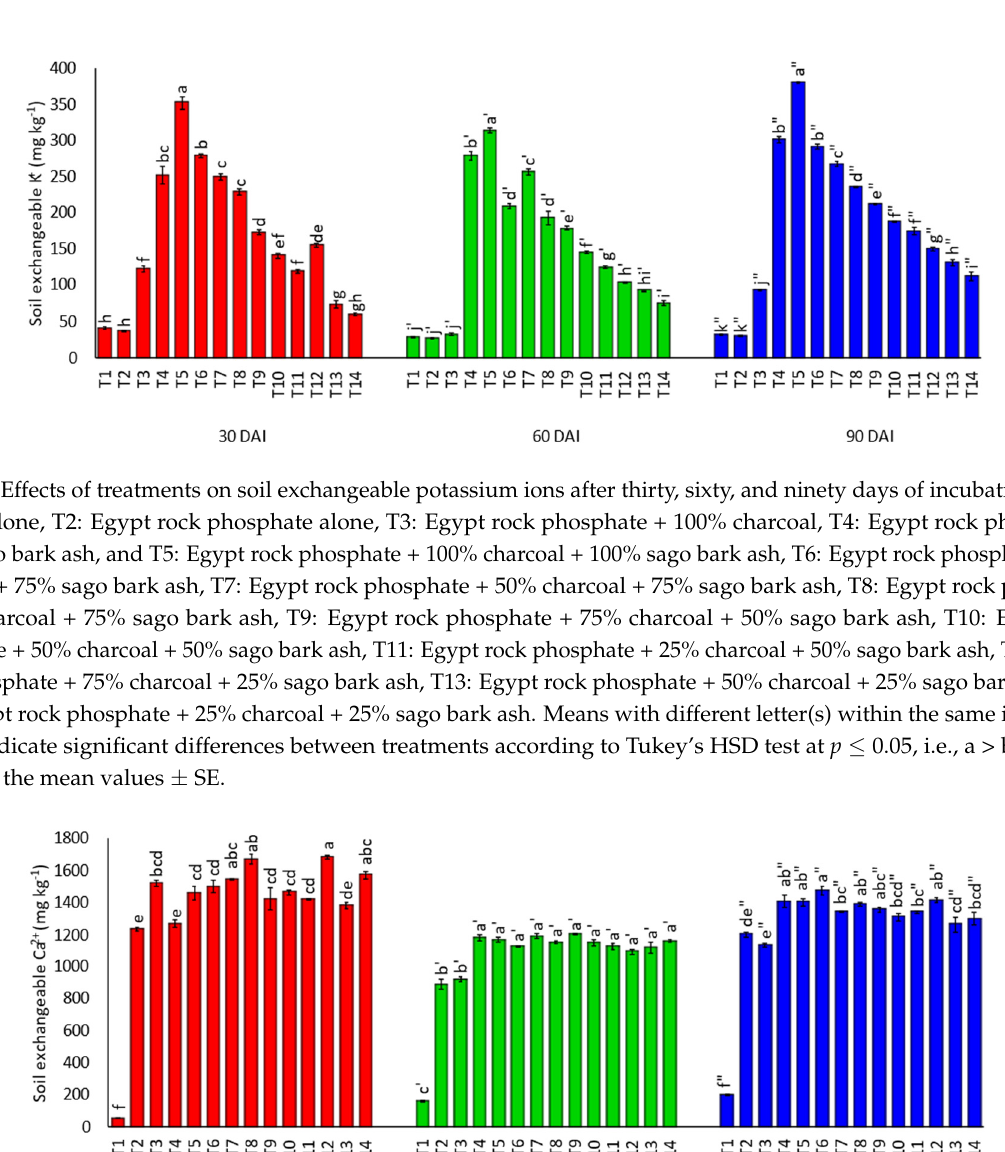
Figure 10. Effects of treatments on soil exchangeable calcium ions after thirty, sixty, and ninety days of incubation, where T1: soil alone, T2: Egypt rock phosphate alone, T3: Egypt rock phosphate + 100% charcoal, T4: Egypt rock phosphate + 100% sago bark ash, and T5: Egypt rock phosphate + 100% charcoal + 100% sago bark ash, T6: Egypt rock phosphate + 75% charcoal + 75% sago bark ash, T7: Egypt rock phosphate + 50% charcoal + 75% sago bark ash, T8: Egypt rock phosphate + 25% charcoal + 75% sago bark ash, T9: Egypt rock phosphate + 75% charcoal + 50% sago bark ash, T10: Egypt rock phosphate + 50% charcoal + 50% sago bark ash, T11: Egypt rock phosphate + 25% charcoal + 50% sago bark ash, T12: Egypt rock phosphate + 75% charcoal + 25% sago bark ash, T13: Egypt rock phosphate + 50% charcoal + 25% sago bark ash, and T14: Egypt rock phosphate + 25% charcoal + 25% sago bark ash. Means with different letter(s) within the same incubation period indicate significant differences between treatments according to Tukey’s HSD test at p ≤ 0.05, i.e., a > b > c. Bars represent the mean values ± SE.